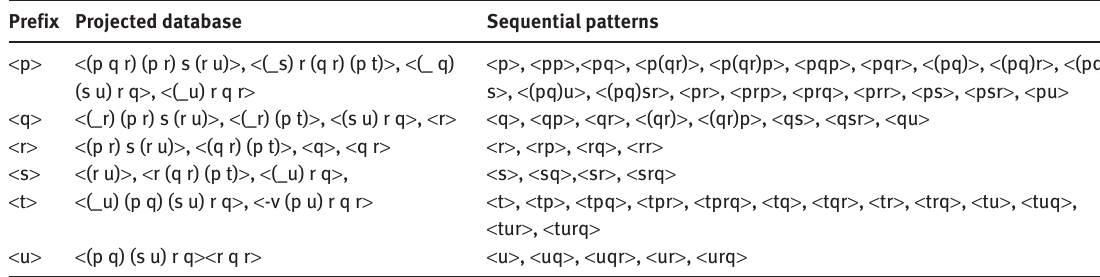
Table 3: Projected Database and Mined